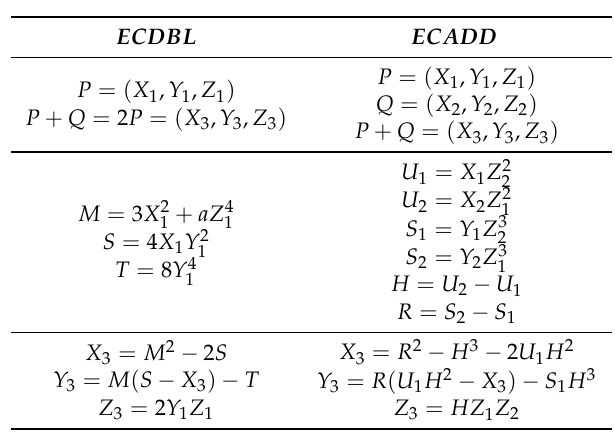
Table 2. Jacobian ECDBL , ECADD